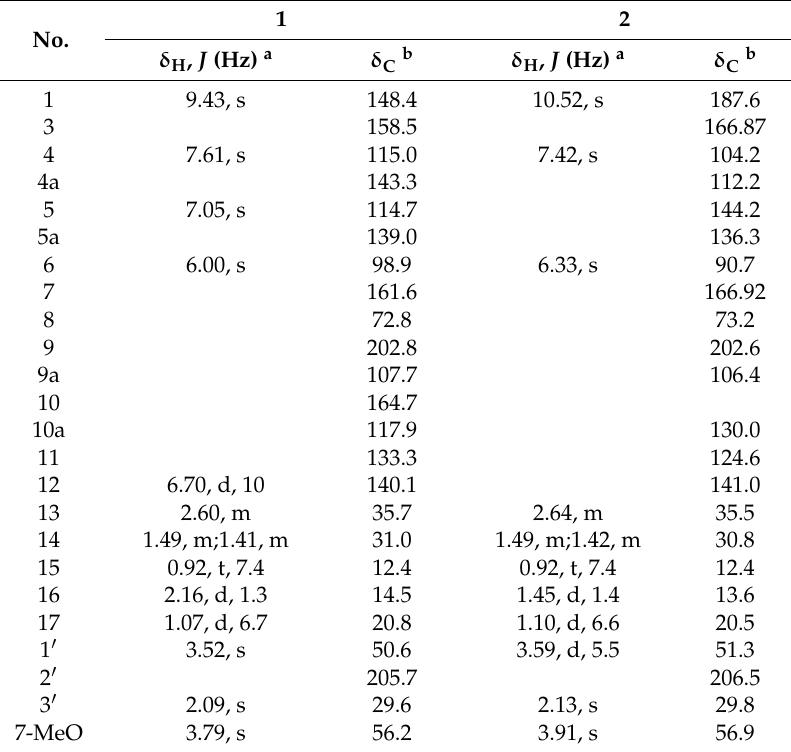
Table 1. NMR spectroscopic data for 1 and 2 in acetone- d 6.